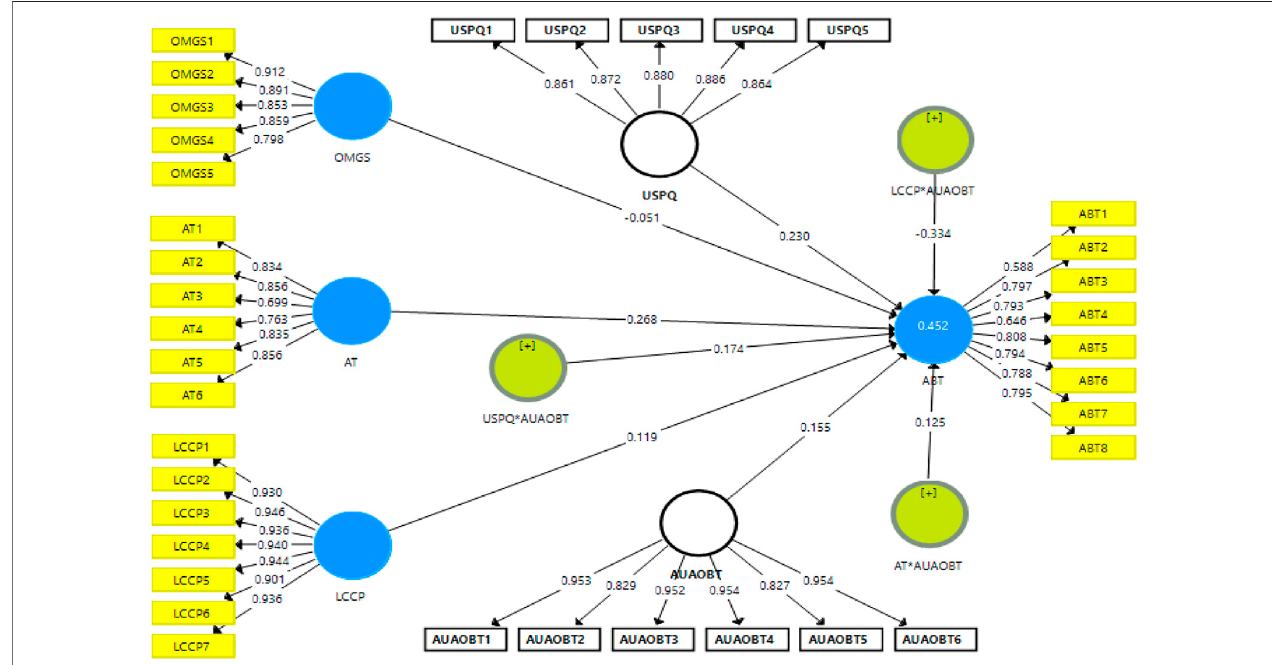
FIGURE 2 | Measurement model